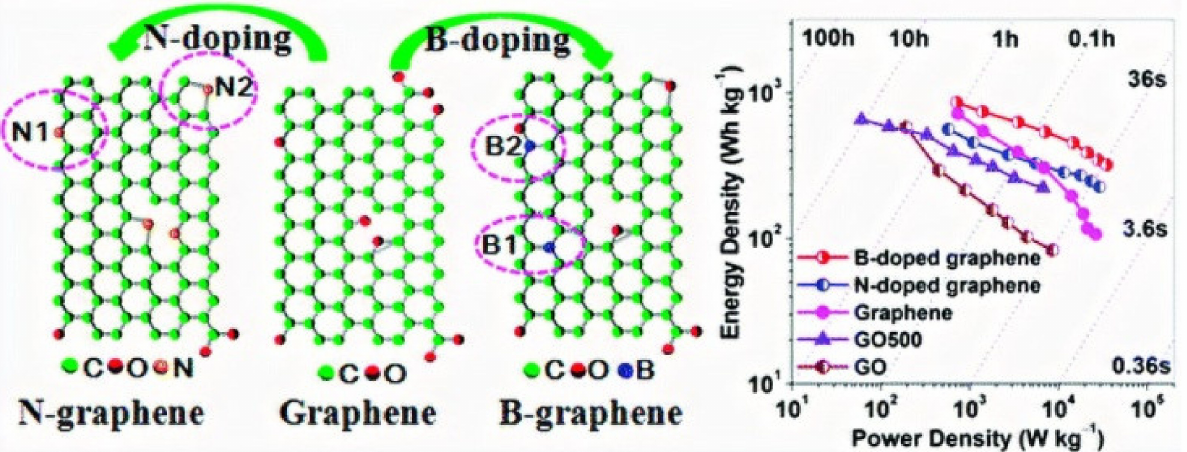
Figure 6. ( Left ) Schematic structure of the binding conditions of Nitrogen (N) and Boron (B) in a graphene lattice, indicated by dotted magenta rings. ( Right ) Ragone plots for pristine graphene, N-doped graphene, B-doped graphene, graphene oxide (GO), and GO500-based cells with lithium metal as the counter/reference electrode. The calculation of gravimetric energy and power den- sity was based on the active material mass of a single electrode. (Reproduced with permission from ref